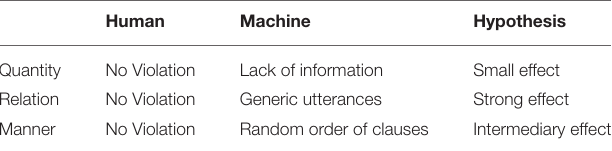
TABLE 1 | Experiment